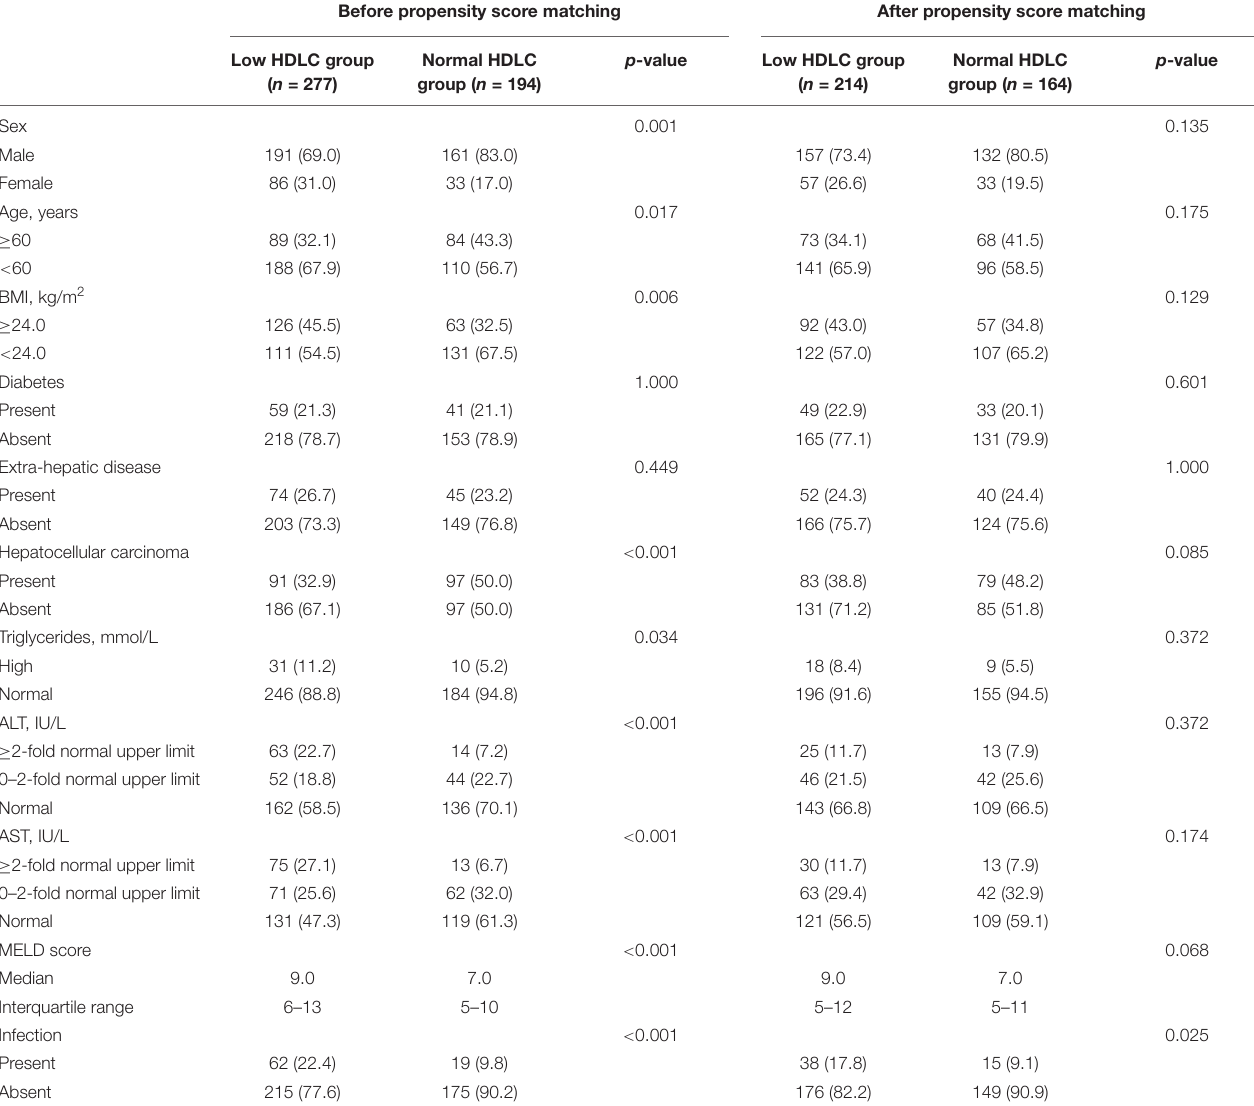
TABLE 2 | Clinical characteristics stratified by